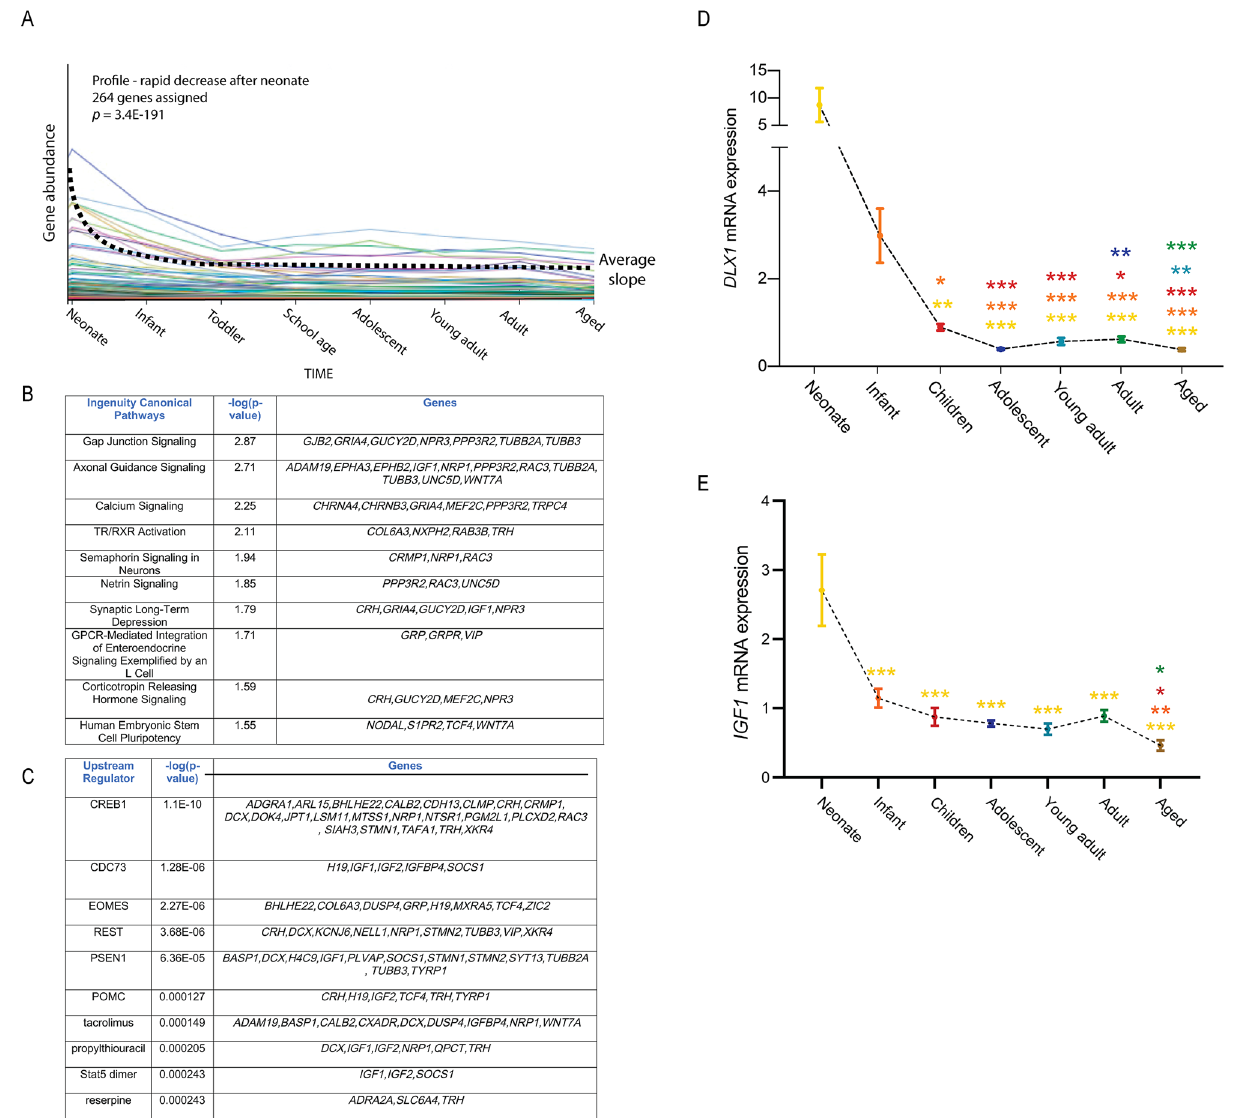
Figure 3. Transcripts whose expression fell rapidly after birth. ( A ) The first major aging-relevant profile that we identified was one in which gene expression dropped rapidly after birth. There were 264 genes associated with this profile. ( B ) Pathway analysis revealed many neuron-associated pathways linked to this profile. ( C ) Potential upstream regulators of the genes associated with this profile as determined through Ingenuity Pathway Analysis. ( D , E ) qPCR confirmed significantly reduced levels of DLX1 ( D ) and IGF1 ( E ) mRNA within the SEZ of older samples. Colours for significance (***) correspond to the colour of the age group used in the comparison. * p < 0.05, ** p < 0.01, *** p < 0.001; Quade’s rank analysis of covariance or analysis of covariance, post hoc tests using